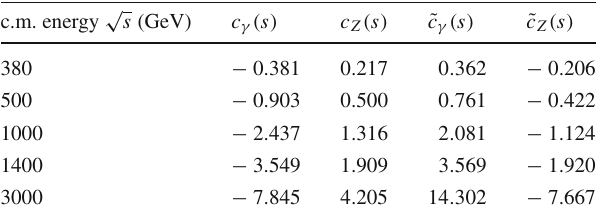
e + beam polarization: R L